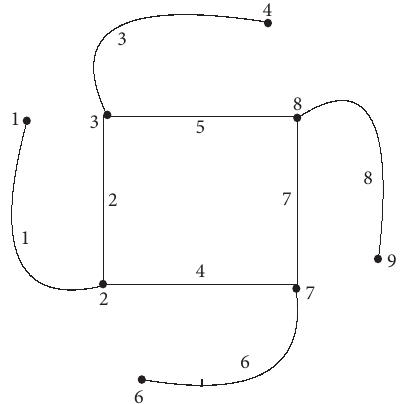
Figure 1: A classical mean labeling of C